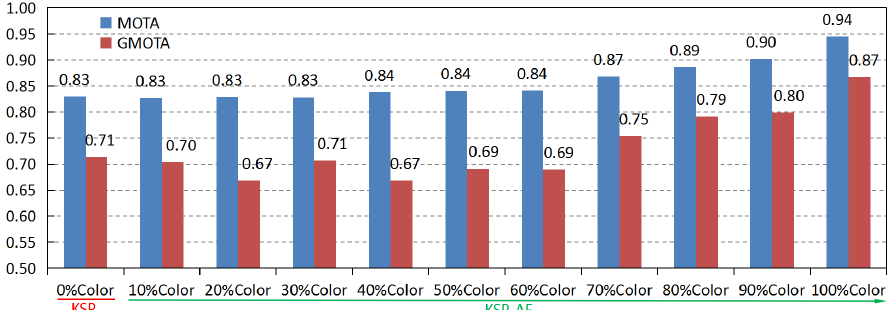
Figure 9. Using only jersey color information cannot largely improve the tracking performance for KSP-AF: (1) 0%Color corresponds the original KSP; (2) both MOTA and GMOTA scores are not largely increased with the escalation of jersey color cues; (3) this experiment is implemented in APIDIS dataset. (2) Tracking experiments with both jersey color and jersey number (APIDIS dataset).